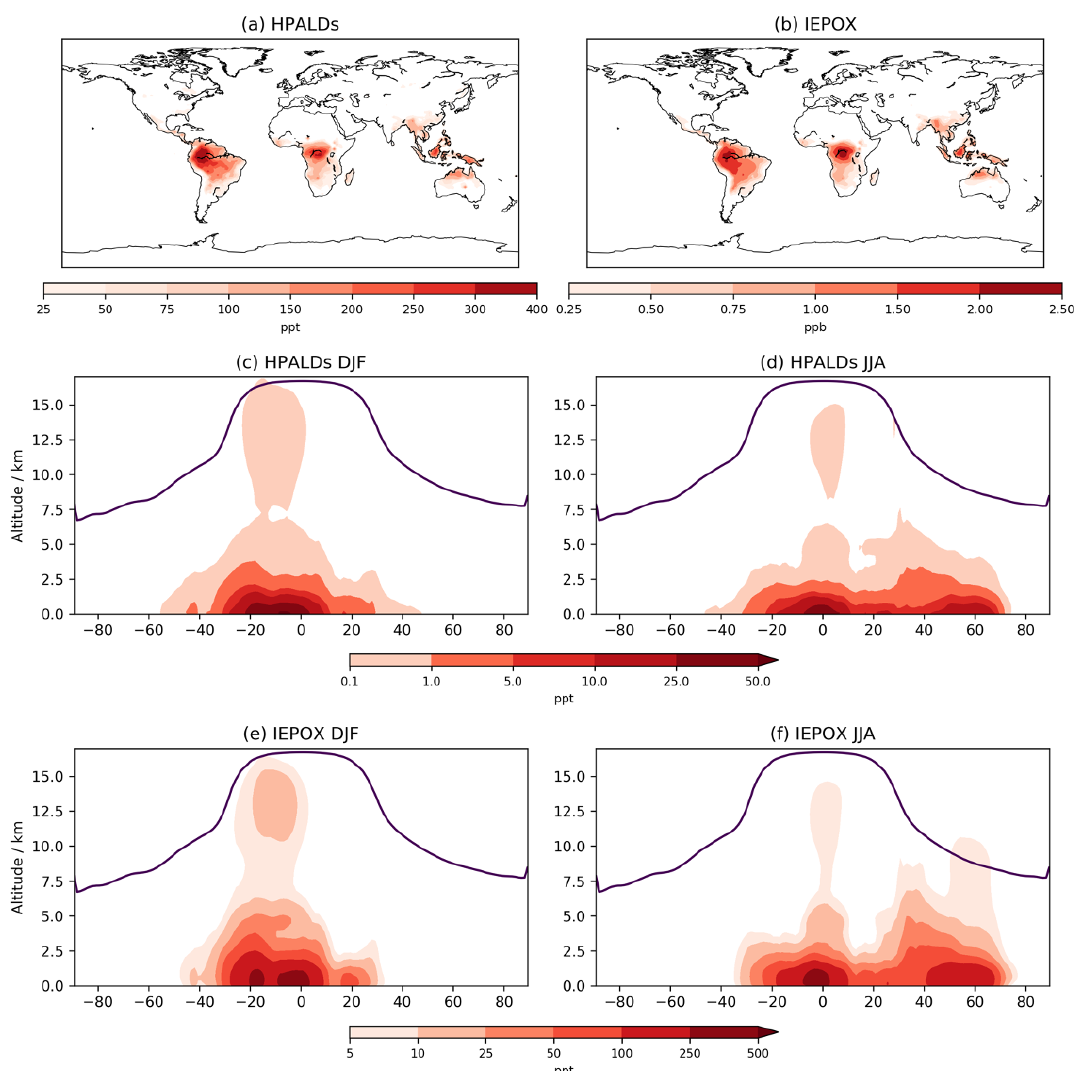
Figure 8. Annual mean mixing ratios for (a) HPALDs and (b) IEPOX over lowest ∼ 100m. DJF (December–January–February) and JJA (June–July–August) zonal mean mixing ratios for HPALDs (c, d) and IEPOX (e, f) ; note the differing scales for HPALD and IEPOX plots and log scales for (c–f)